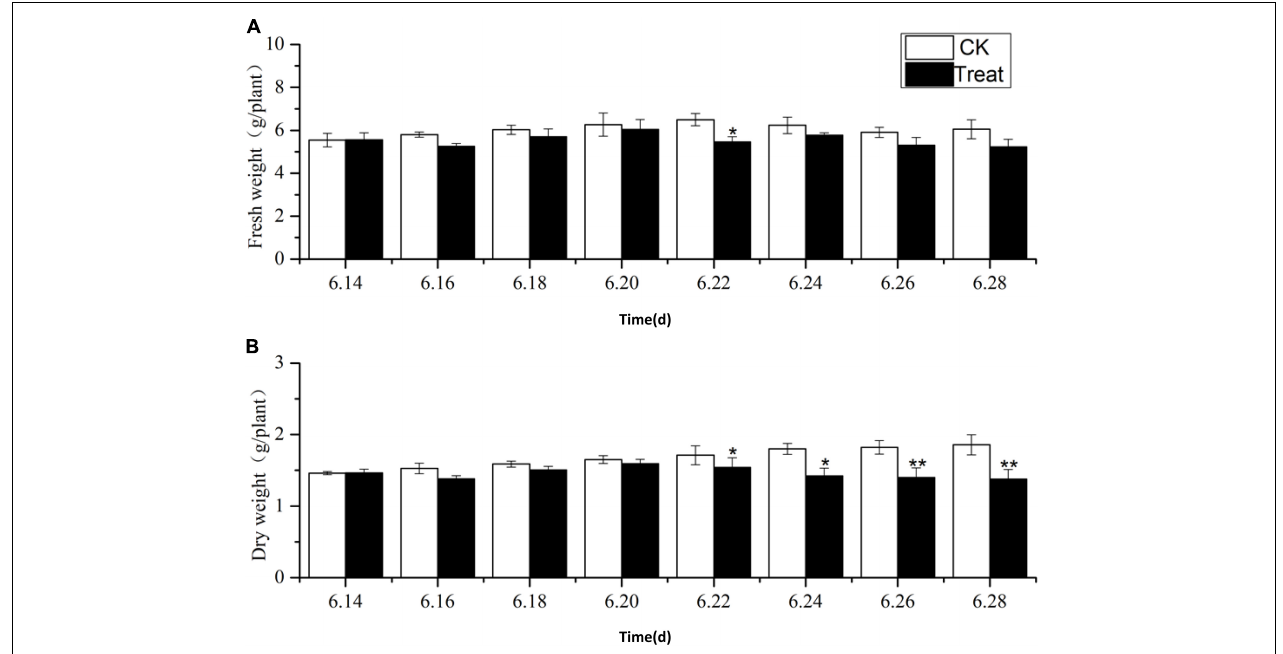
FIGURE 1 | Effects of cold stress on fresh weight and dry weight of ginseng during the flowering stage. The X axis represents the sampling time. (A) Represents the change of fresh weight under cold stress. (B) Represents the change of dry weight under cold stress. * p < 0.05 and ** p < 0.01, compared with control group. Vertical bars indicate the mean value ± standard deviation from three independent experiments. The same